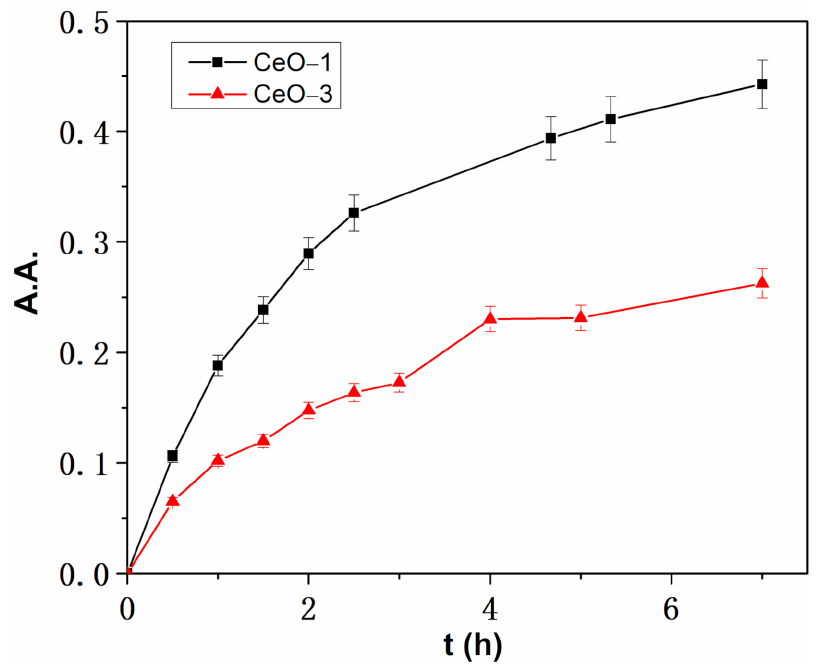
Figure 14. Evolution of the DPPH absorbance over time in the presence of cerium oxide